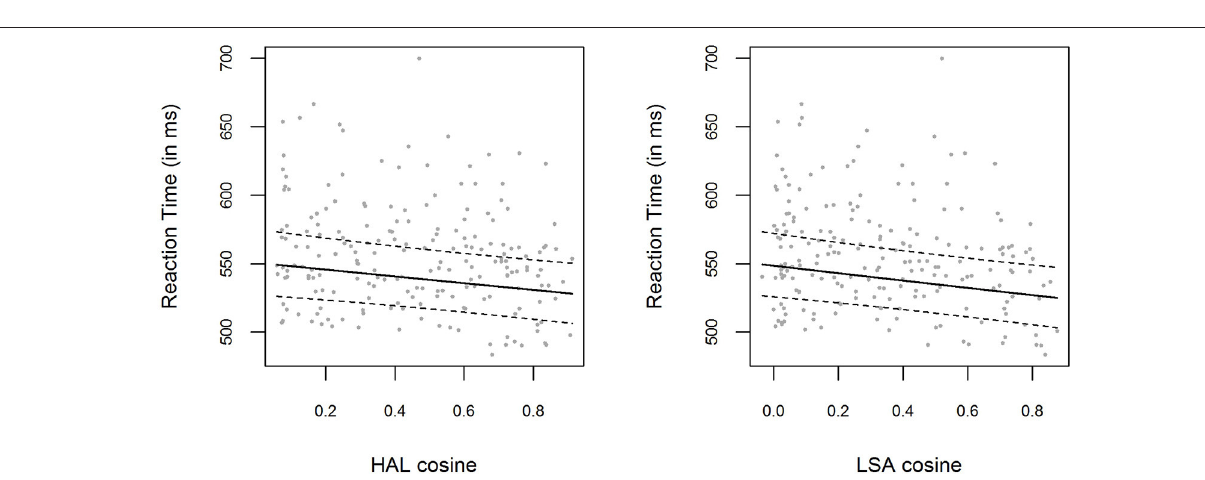
Figure 3 . Including a fixed effect for LSA cosine